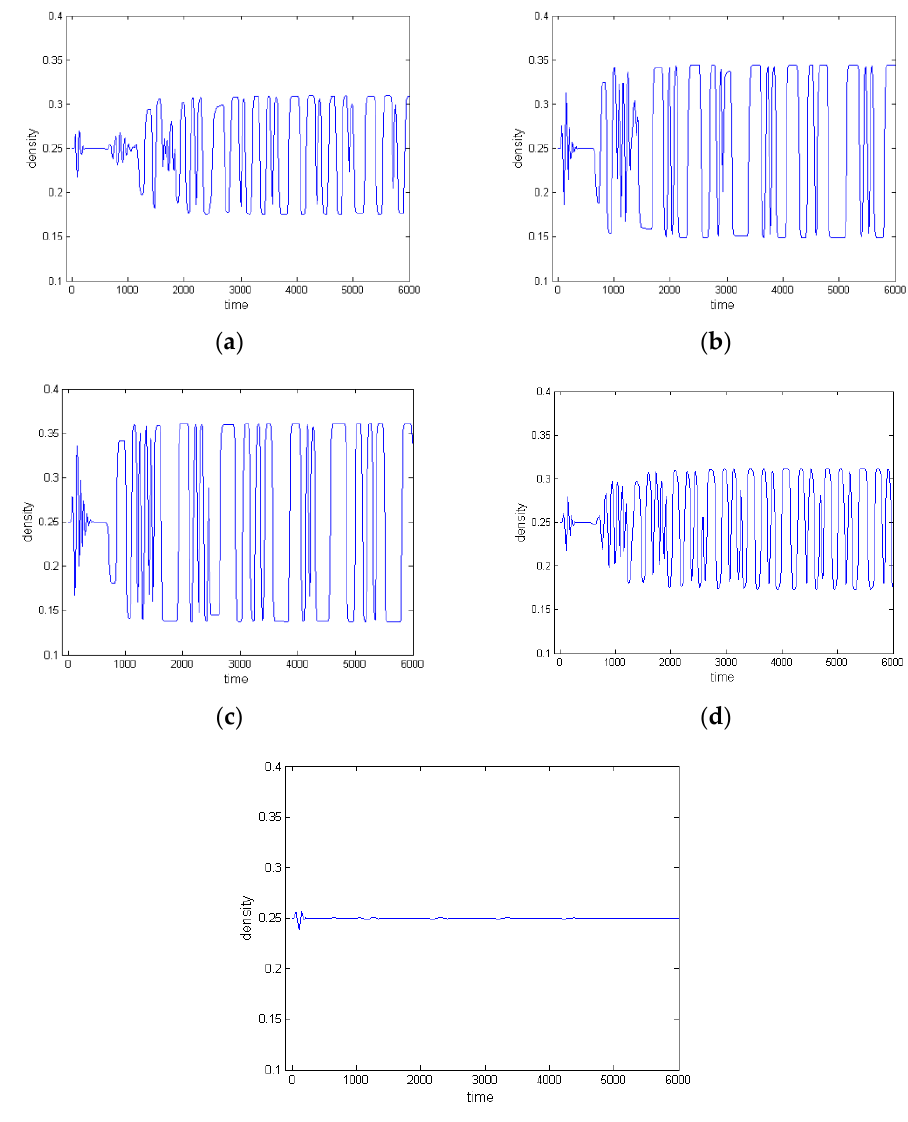
Figure 5. Traffic wave-developing process of the new model when β = 0.06 and d ( k ) = round ( 3 + ( )=round(3+2sin( )) d k k , in which ( a ) in the first =500 t time step, ( b ) after =500 t time step. 2sin ( k )) , in which ( a ) in the first t = 500 time step, ( b ) after t = 500 time step.